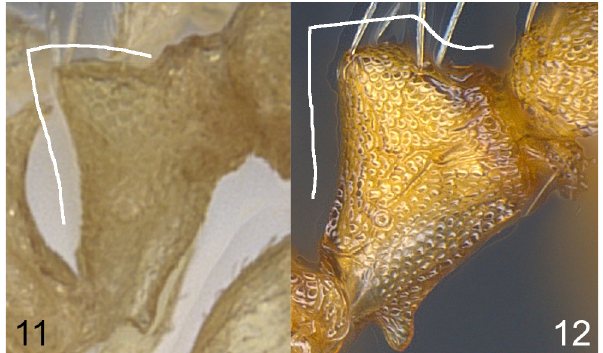
Figs 11–12. Petiole shape variation in workers of Temnothorax Mayr, 1861, photos from www.antweb.org, specimen identifiers in parentheses. 11 . T. atomous (Cagniant & Espadaler, 1997), type specimen from Morocco (CASENT0915391), photo by Will Ericson, petiole dorsal profile with a single edge and no